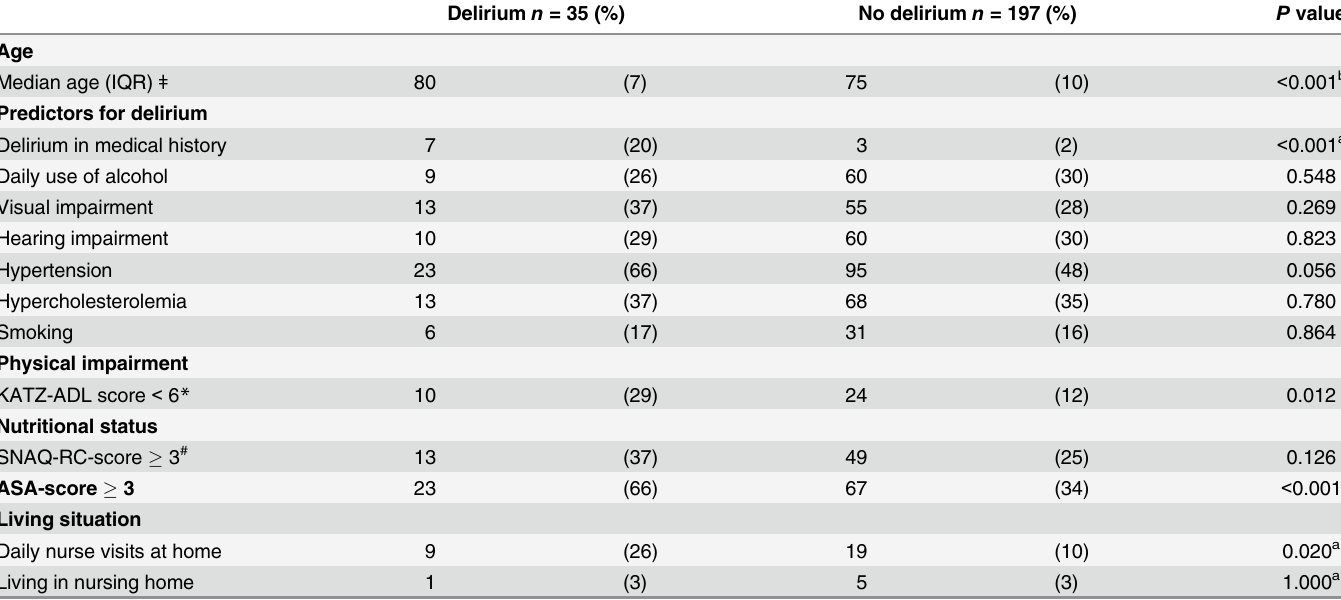
Table 2. Pre-operative variables in relation to onset of postoperative delirium of all. included patients having elective surgery for AAA or colorectal